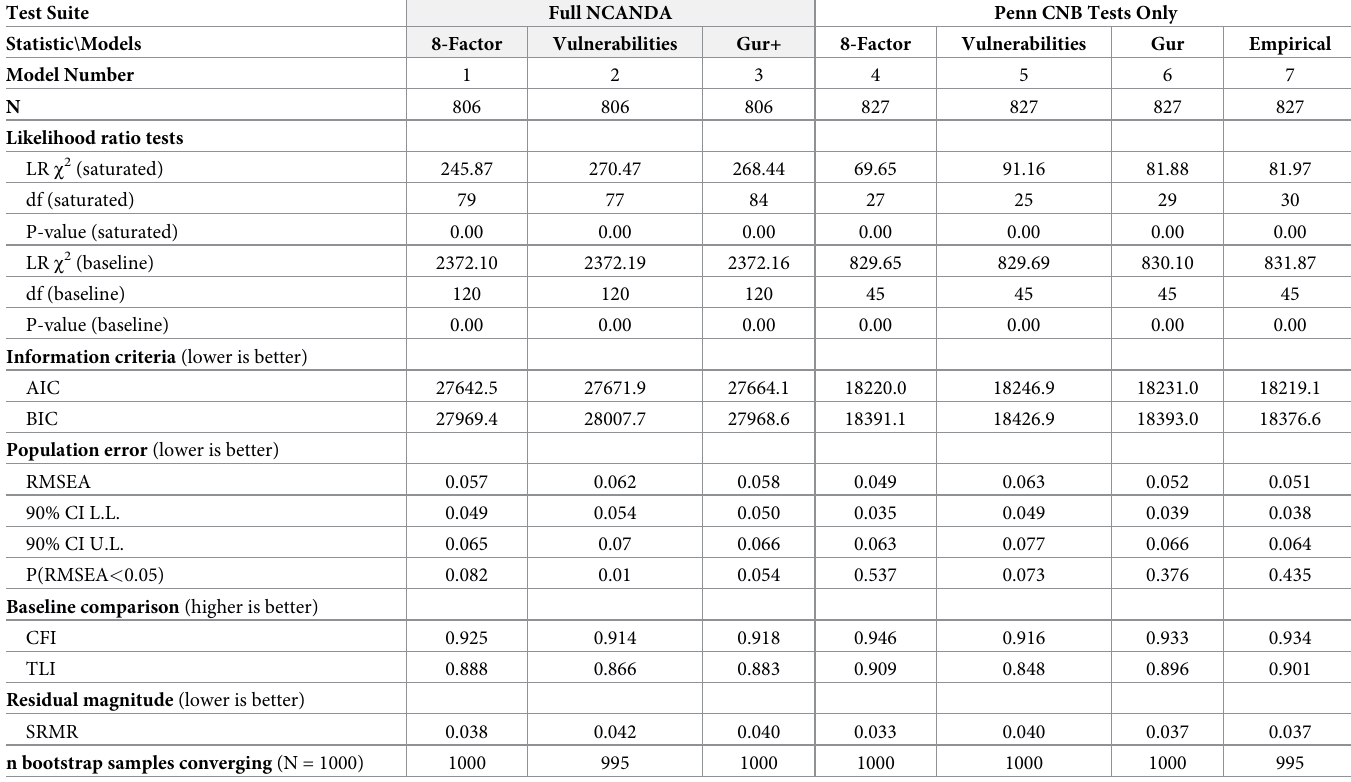
Table 2. Confirmatory factor analysis model fit